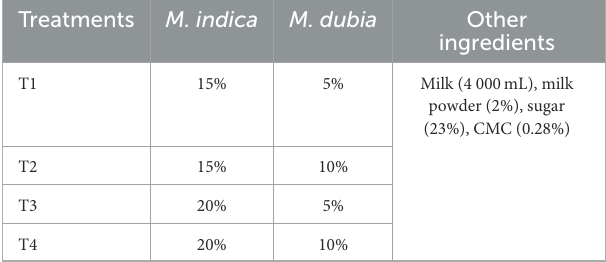
TABLE 2 The ingredients used in the ice cream preparation.